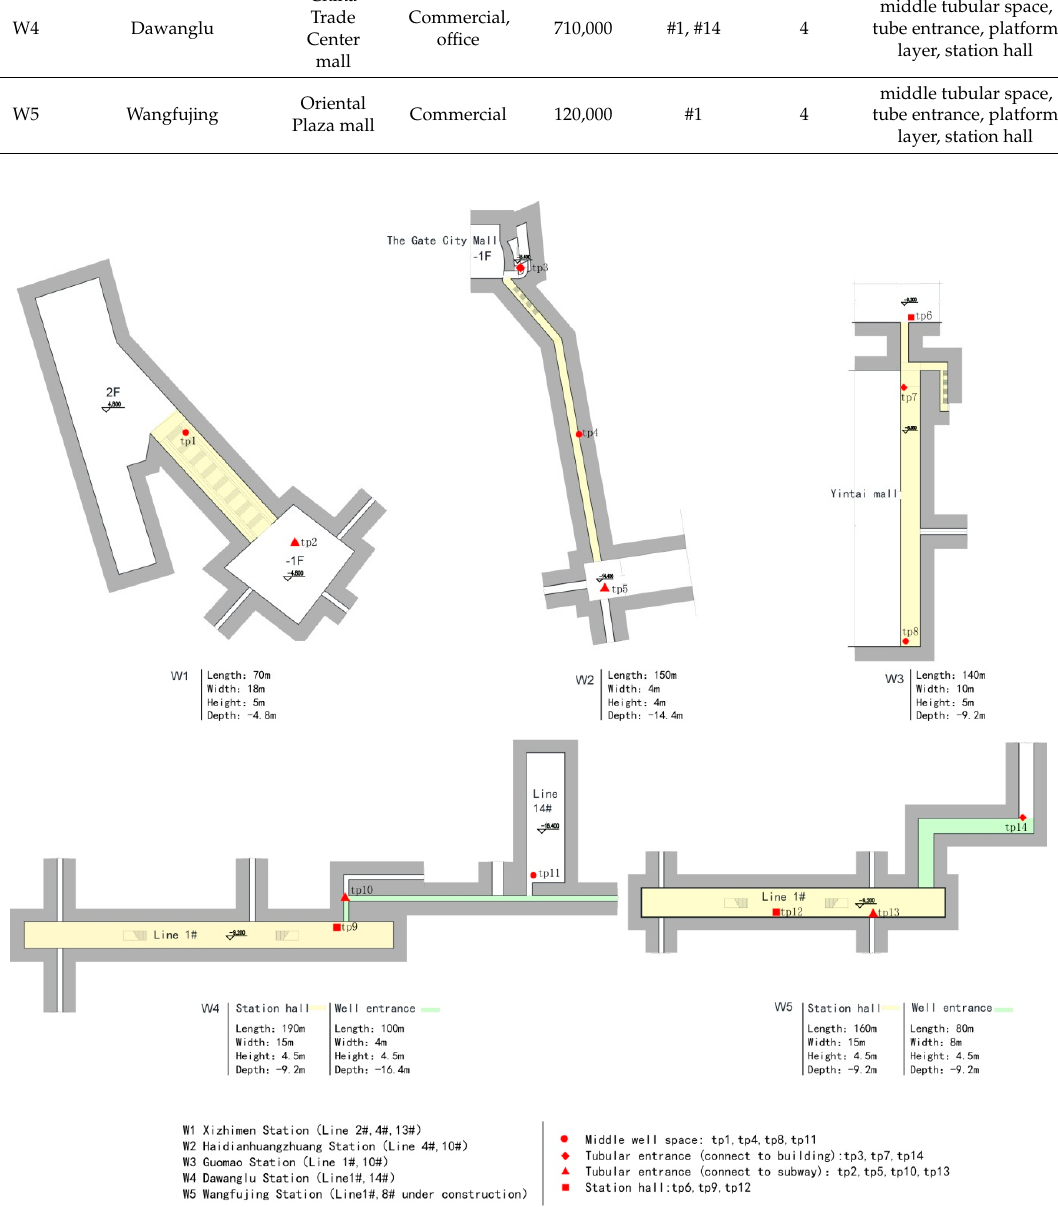
Figure 5. Test station space plan and test points location.